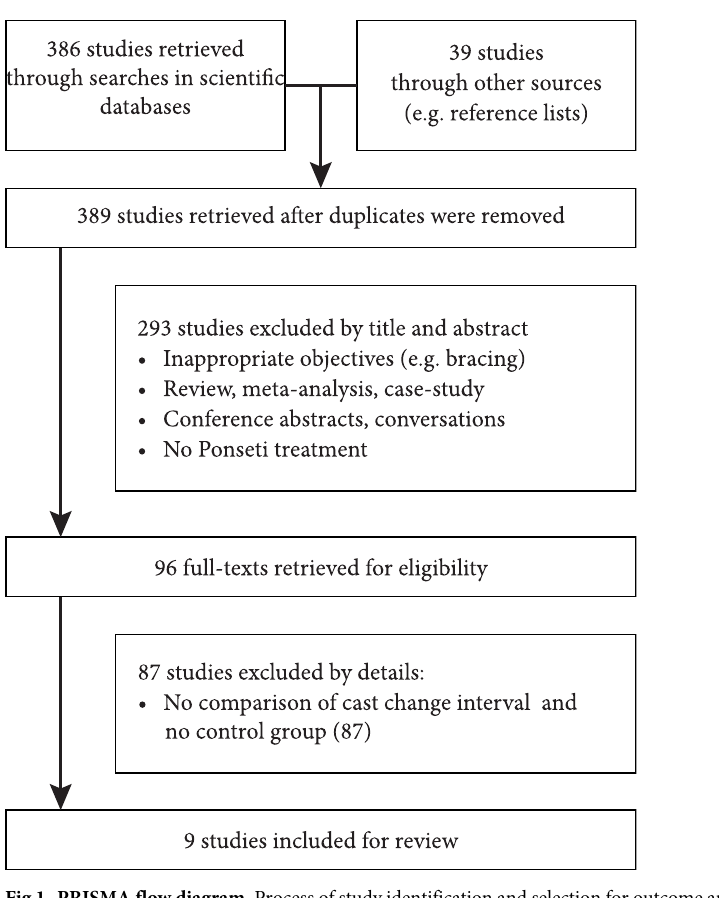
Fig 1. PRISMA flow diagram. Process of study identification and selection for outcome analysis